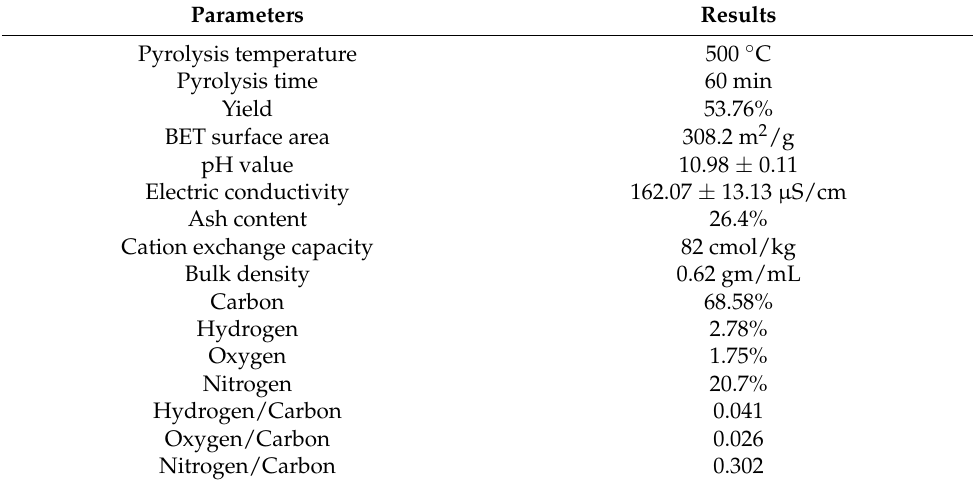
Table 3. Physicochemical characteristics of biochar.